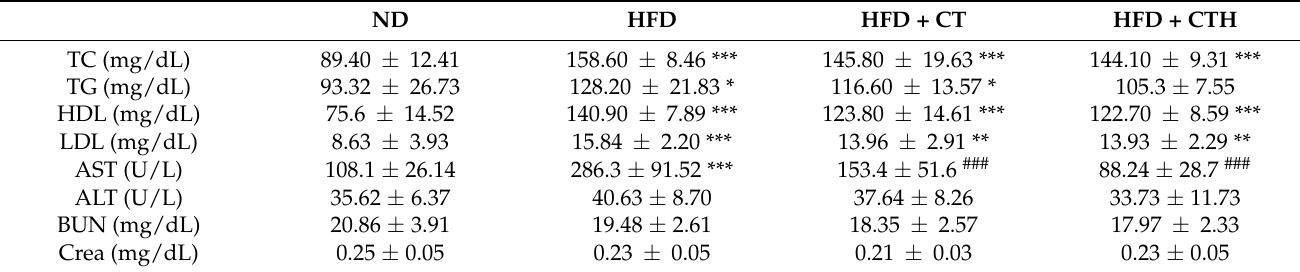
Table 1. Serum biochemical assessment.